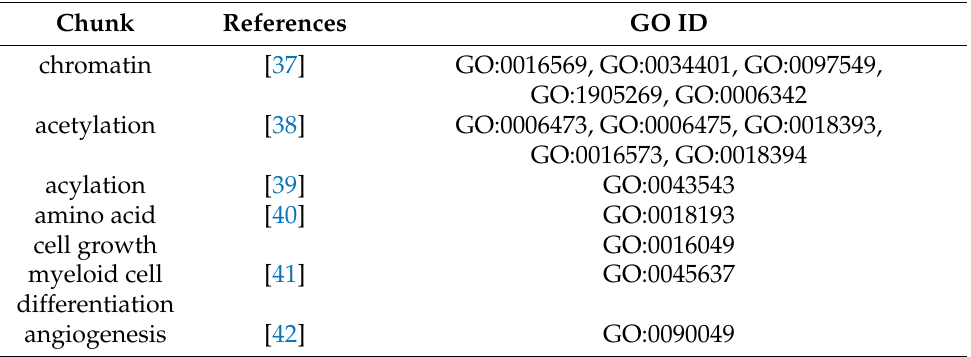
Table 2. GO terms of the biological processes selected by up-regulated TF-DEGs returned by Method 1. We note that the majority of GO labels are associated with the terms chromatin and acetylation, while there is only one GO label (GO:0045637) directly correlated to